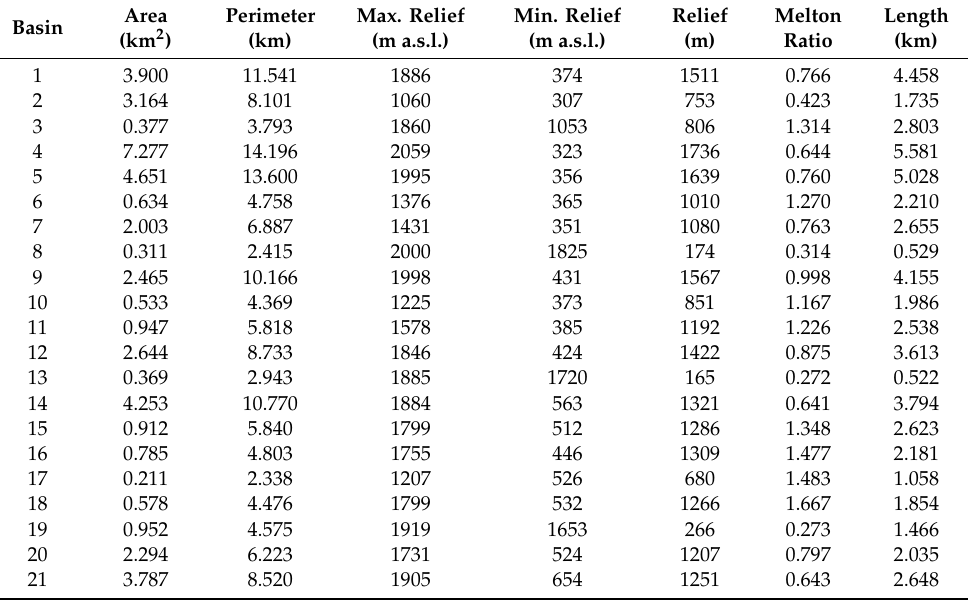
Table 1. Main morphometric parameters of the 21 basins in the study